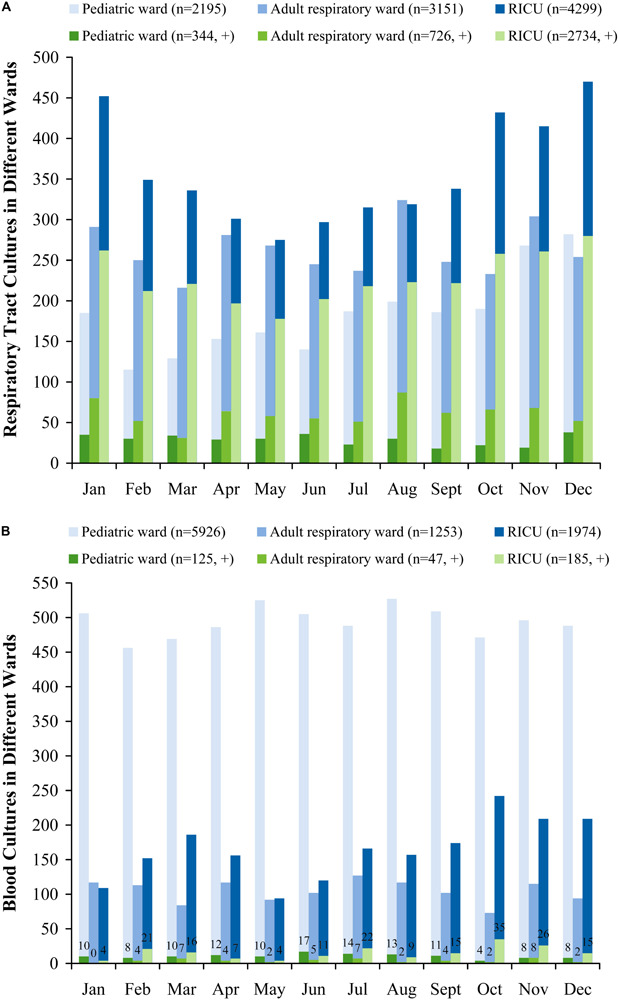
Monthly distribution of sampling (A) respiratory tract cultures, (B) blood cultures in patients with lower respiratory tract infections from the pediatric ward, adult respiratory ward, and respiratory intensive care unit (RICU). More respiratory tract and blood cultures of LRTI patients from three wards were performed in all seasons (January to December) than in cold seasons (October to December). RICU, respiratory intensive care unit.